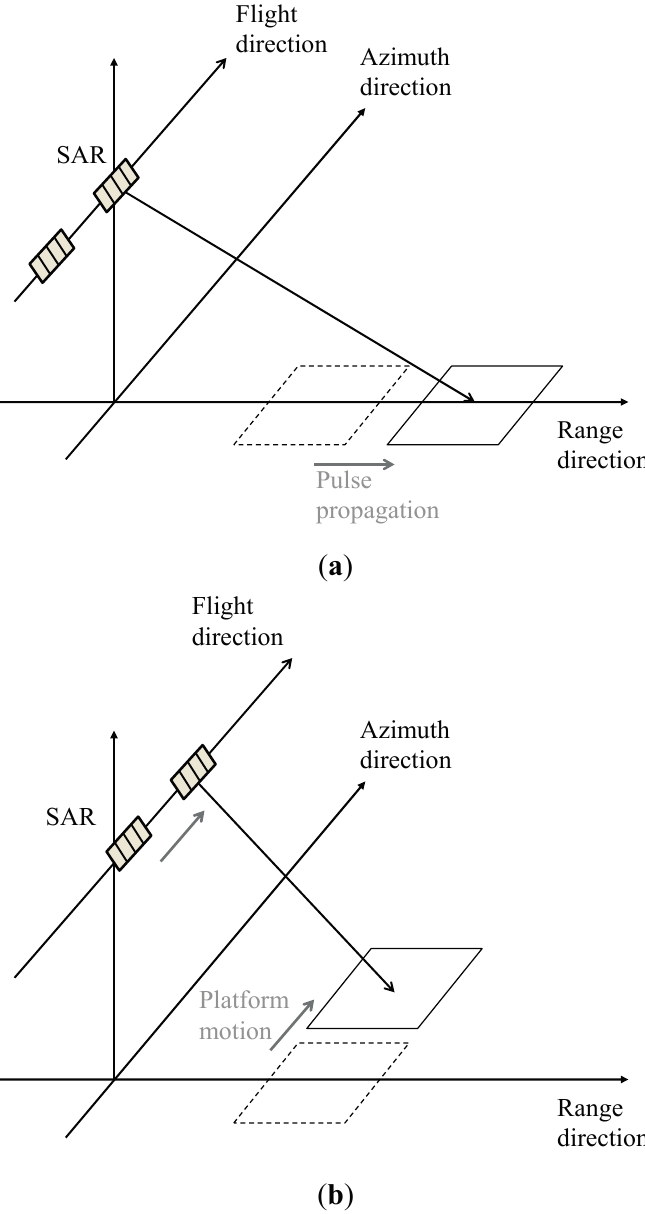
Figure 2. Schematic images of altering the locations of the calculation areas. ( a ) pulse propagation in the range direction; ( b ) platform motion in the azimuth